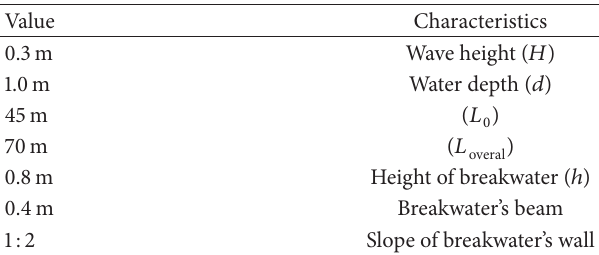
Figure 3: Comparison of generated solitary wave with Sagnita’s results. Table 1: Wave flume, solitary wave, and breakwater